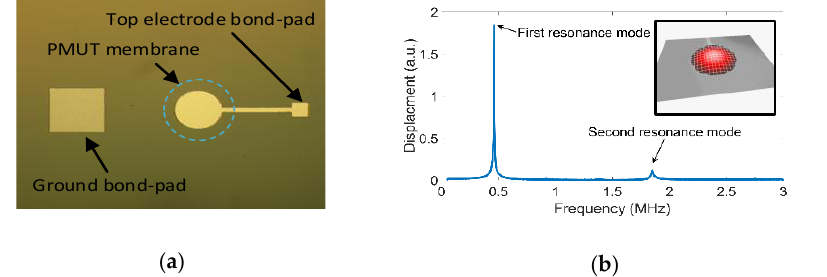
Figure 4. (a) The optical microscopic image of the fabricated PMUT; (b) the measured frequency response and the measured deflection (inlet) by